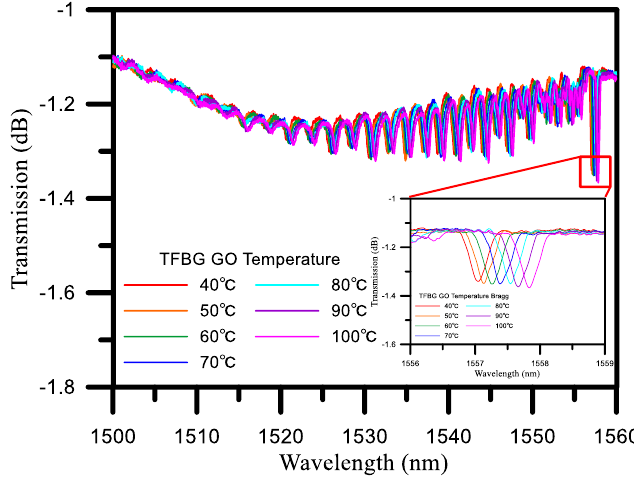
Figure 6. Effects of temperature on TFBG GO wavelengths.